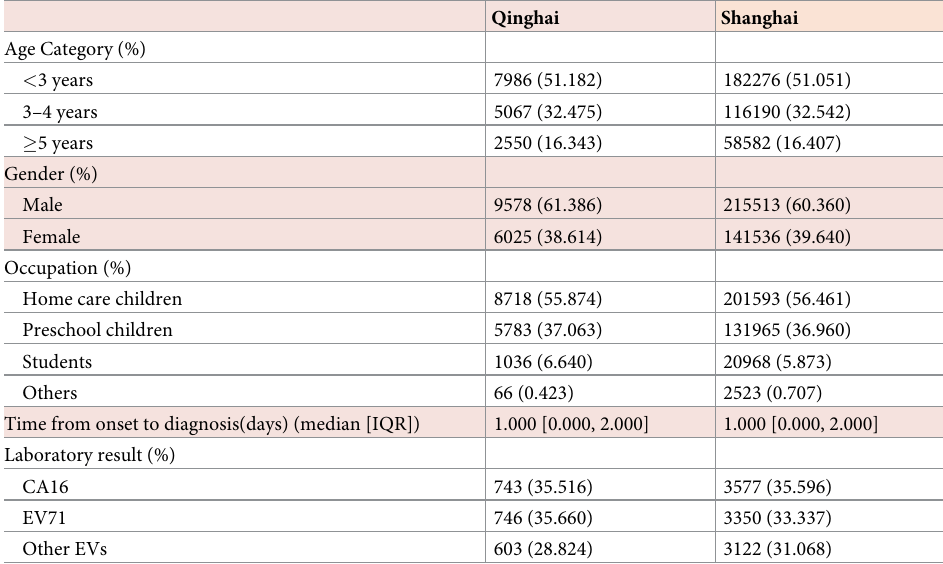
Table 1. Characteristics of all cases of hand, foot, and mouth disease in Qinghai and Shanghai,